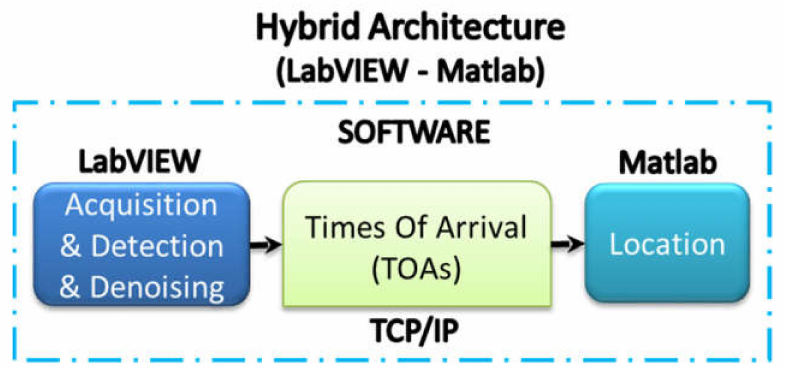
Figure 11. Hybrid processing system for detecting and locating the